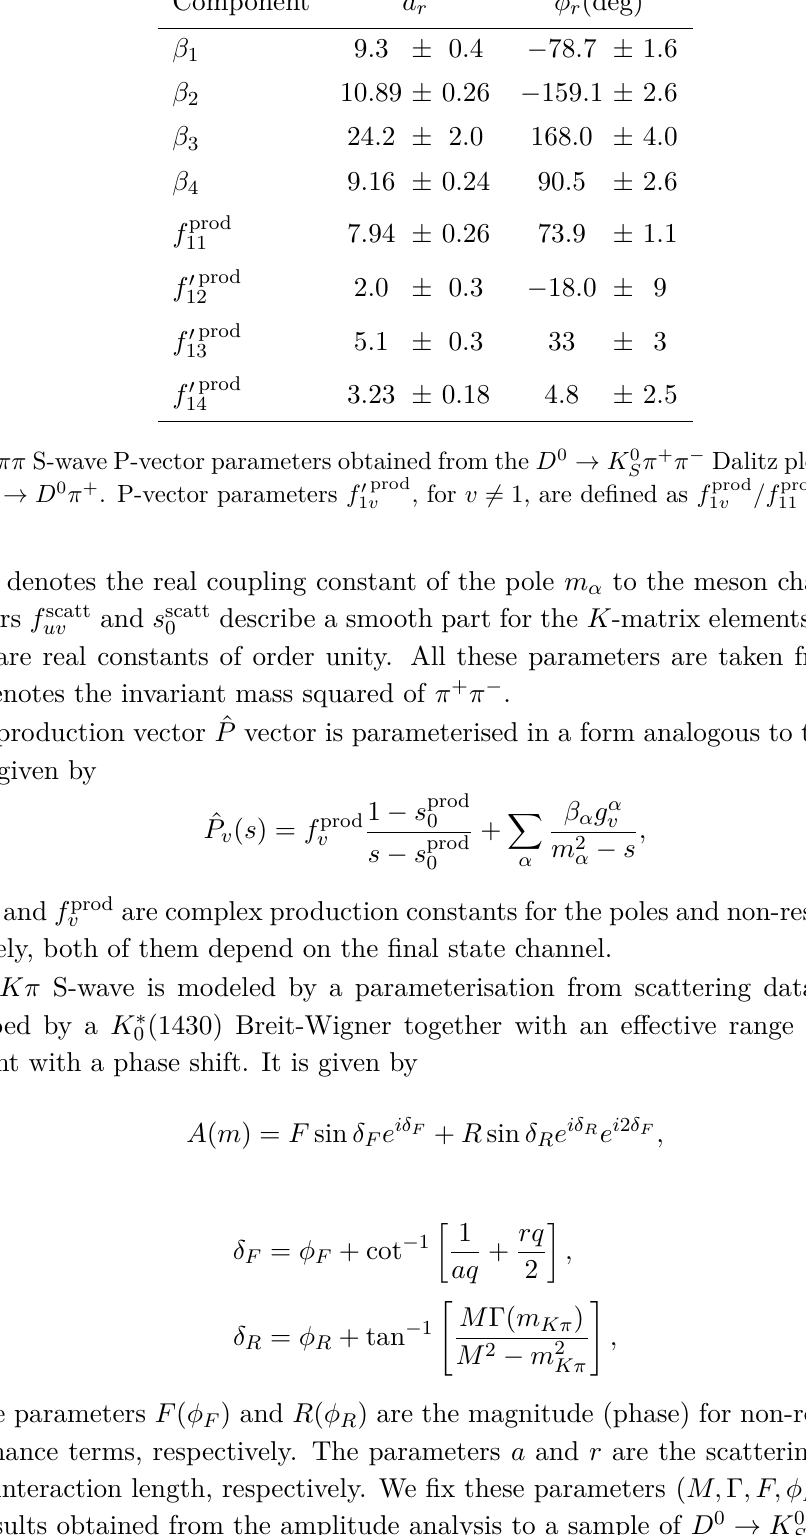
Table 5 . ππ S-wave P-vector parameters obtained from the D 0 → K 0 from D ∗ + → D 0 π + . P-vector parameters f 0